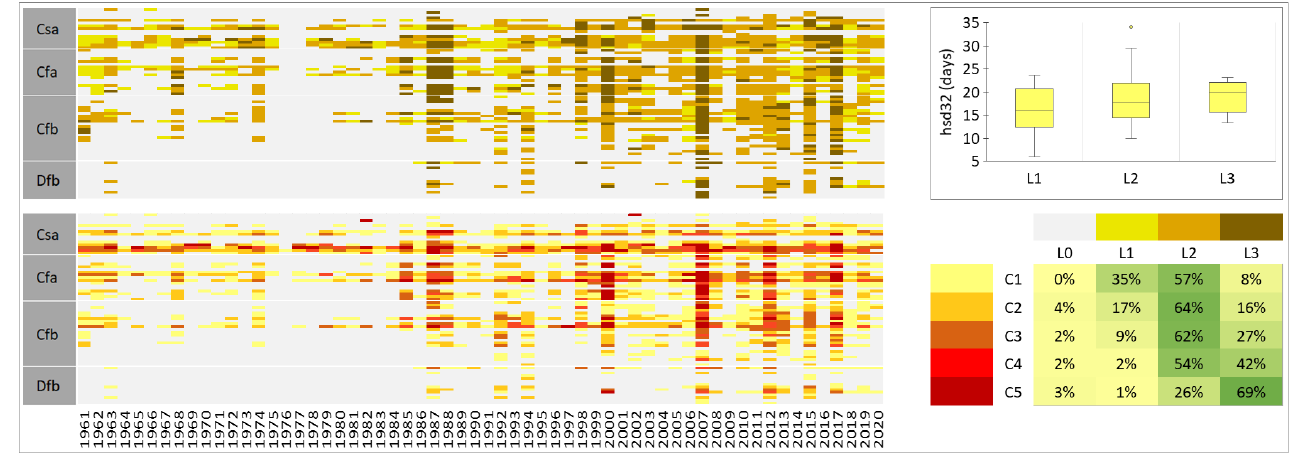
Figure 8. Left panel: Spatio-temporal variation of yearly maximum EHEs intensity represented by categories of hsd indicator and EHF sev levels. Right upper panel: Distribution of hsd32 values by EHF sev levels. Right lower panel: Percentage of different hot spells categories (C1–C5) associated with EHF sev levels